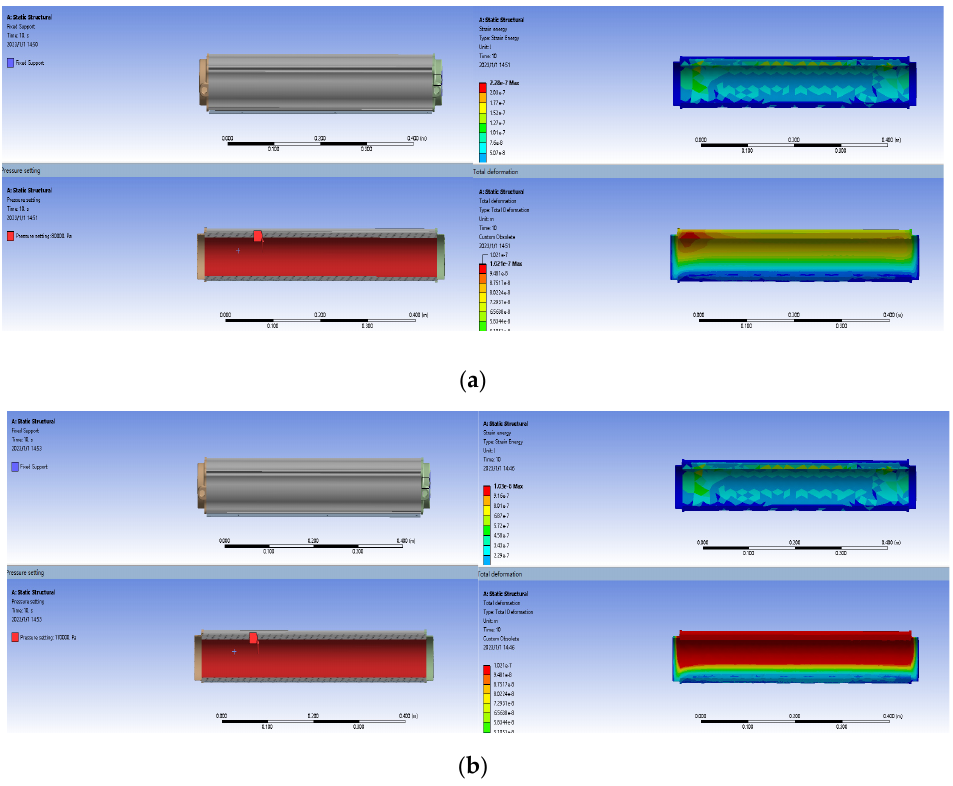
Figure 3. Three-dimensional structure of molecular sieve bed.